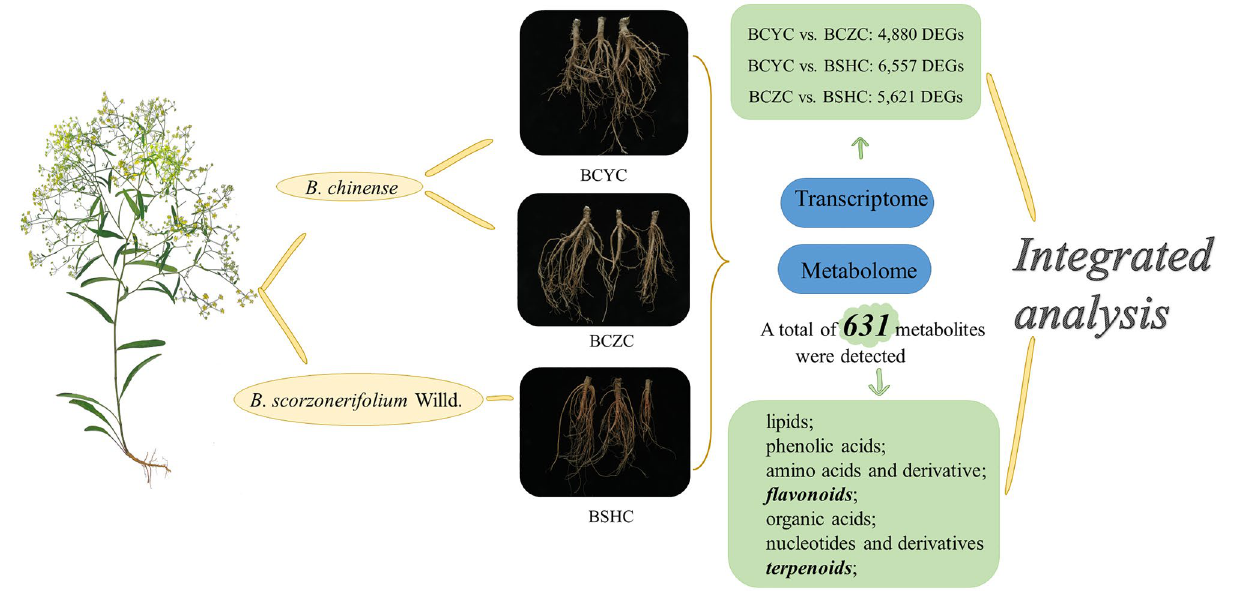
Figure 6. The figure of experimental materials and the experimental